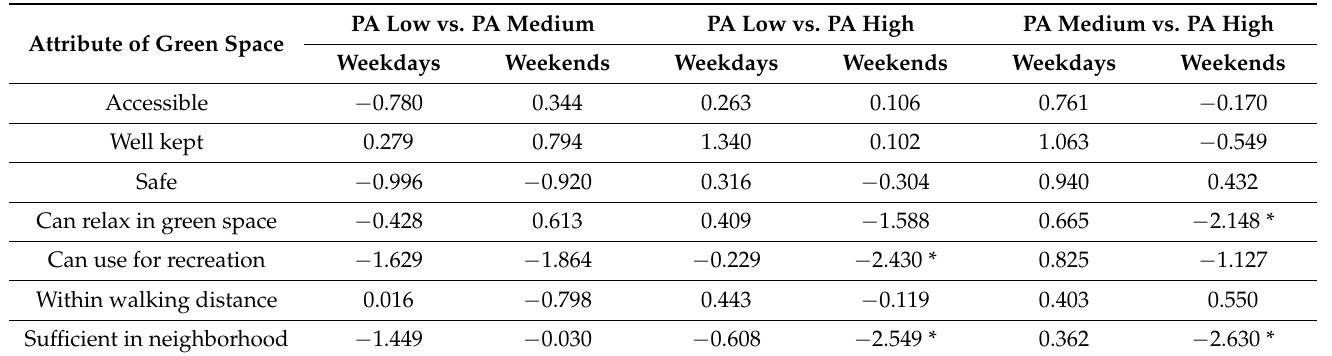
Table 3. Attributes of green space comparison of people with different activity levels (pairwise comparisons using the Mann-Whitney U-value